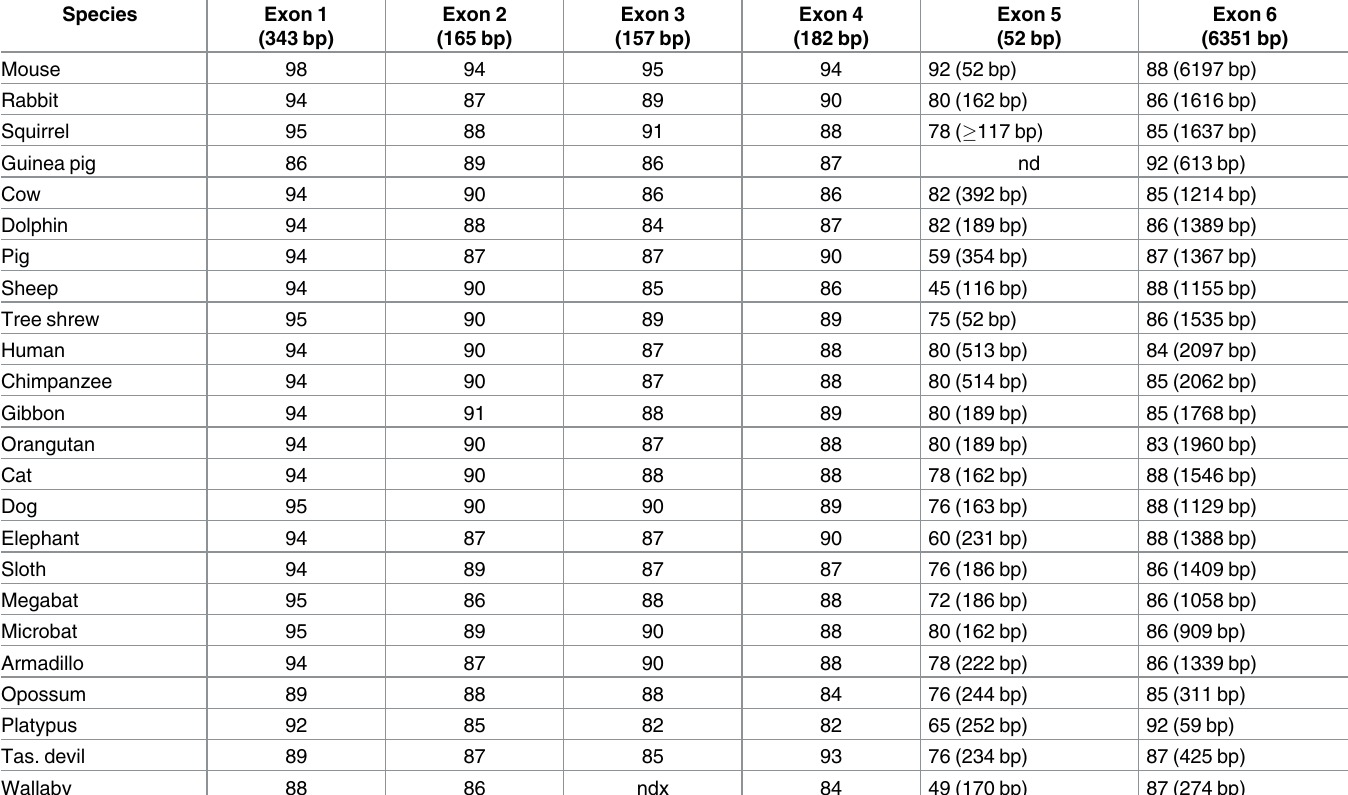
Table 2. Nucleotide identity with rat Igf1 exons